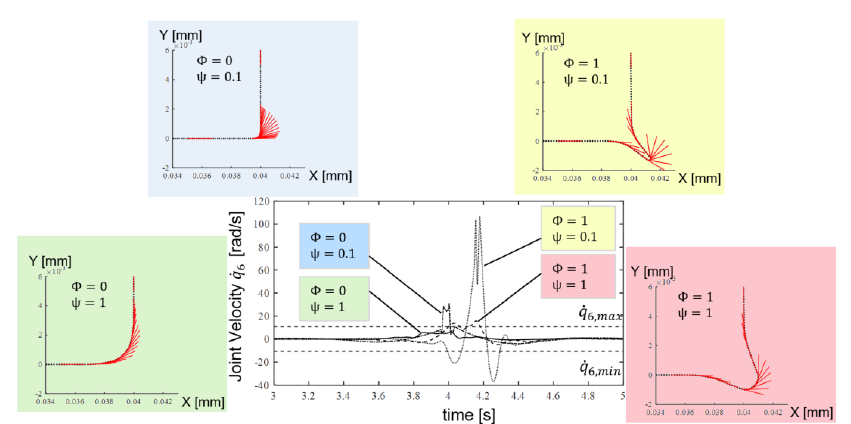
Figure 3. Influence of different smoothing and stretching parameters on the robot joint values along the execution (here, the 6th joint of Kuka KR6).